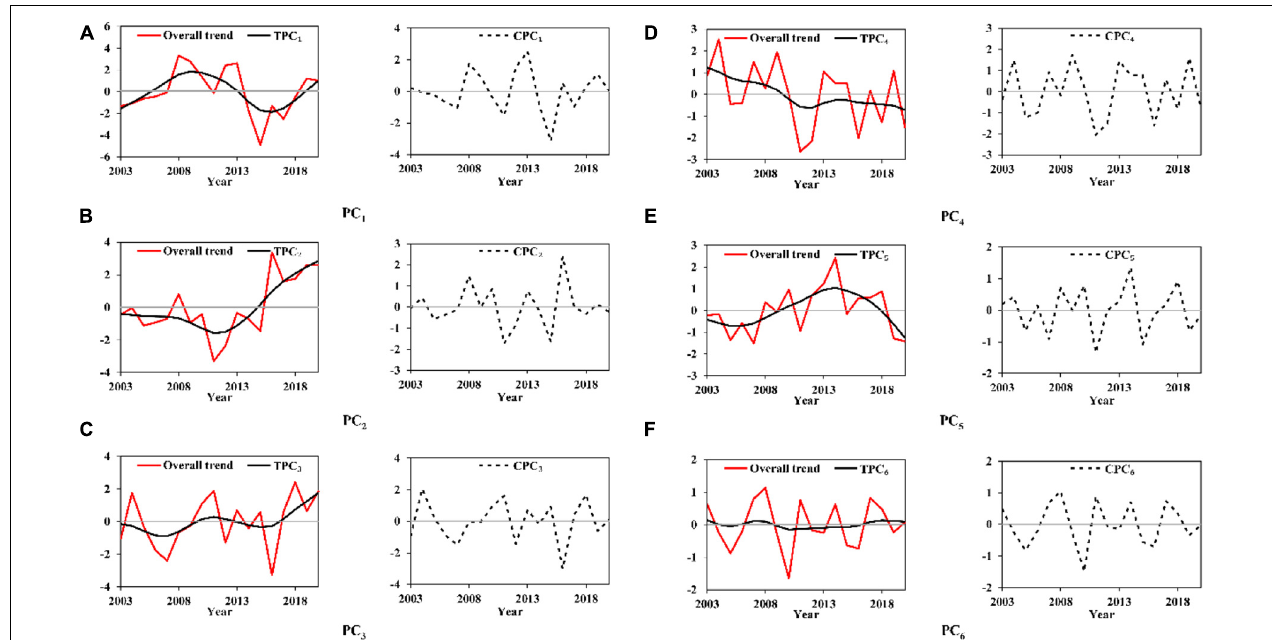
FIGURE 5 | Overall, annual and interannual trends (CPC i and TPC i ) of each principal component PC i for the sea surface temperature at the spawning and feeding ground to Ommastrephes bartramii (Panels A–F indicate the Hodrick-Prescott filter analysis results of PC 1 -PC 6 ).